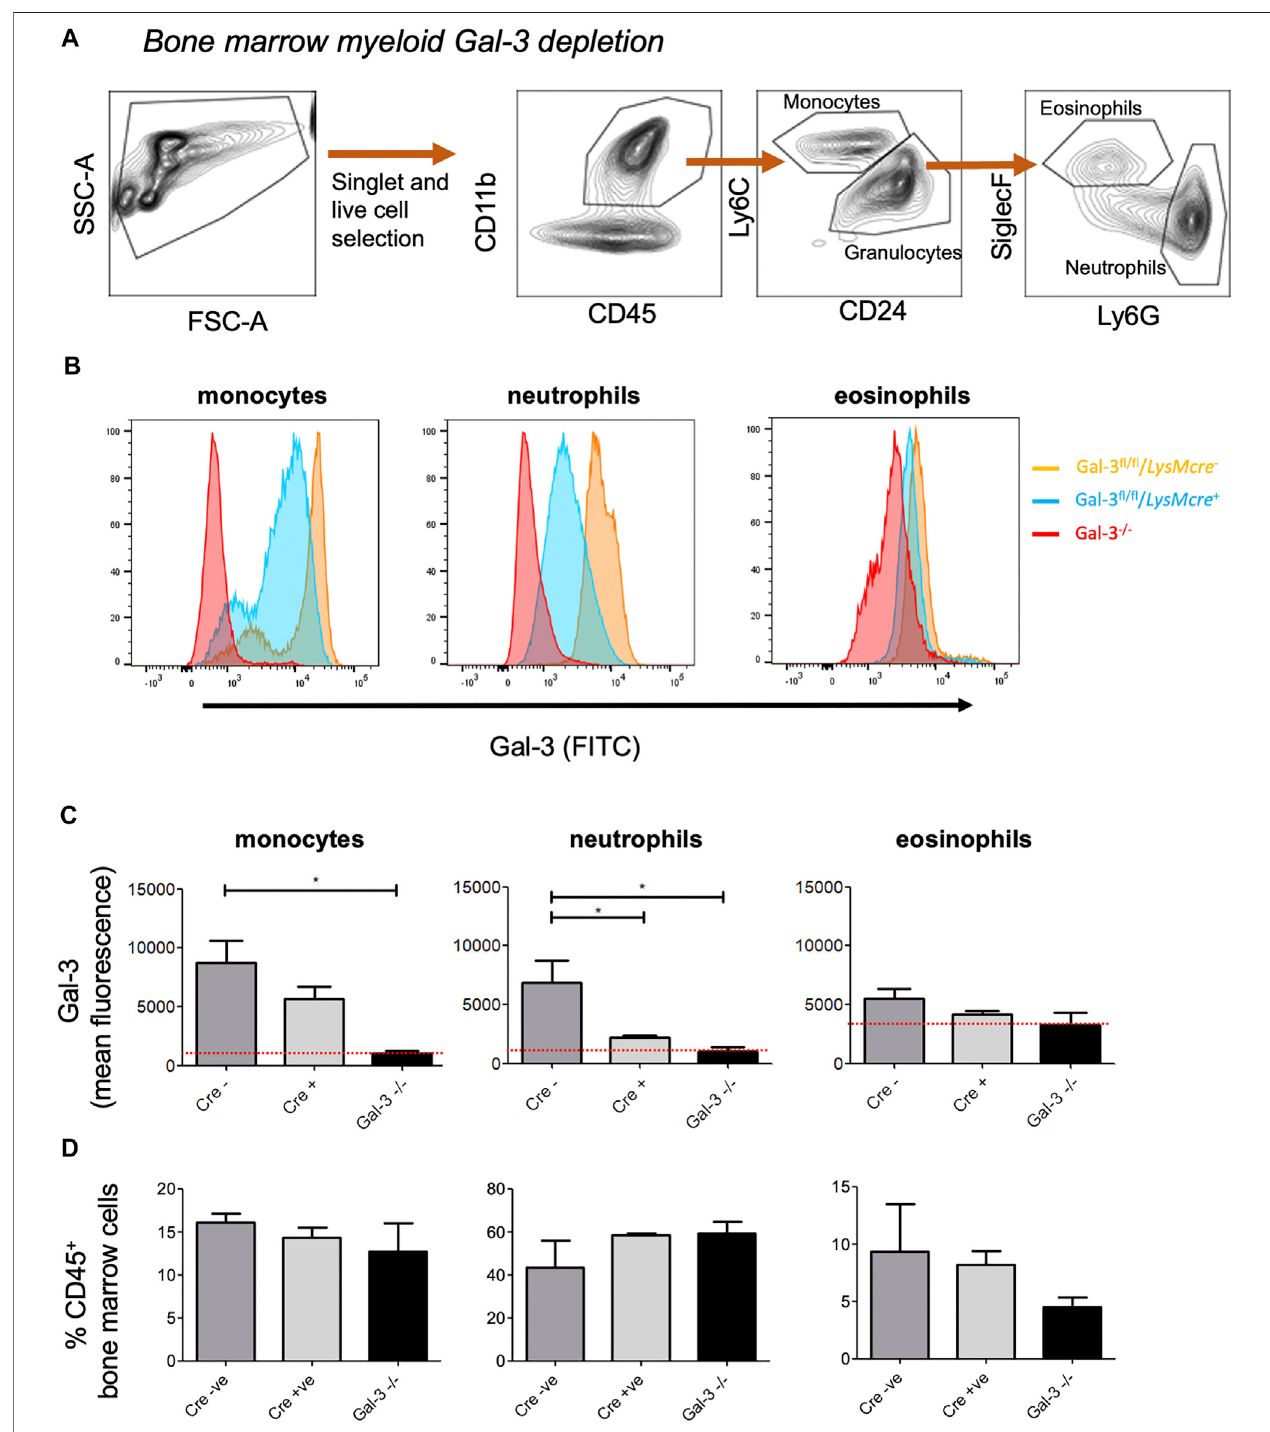
FIGURE 1 | – Con fi rmation of Myeloid cell Gal-3 depletion using bone marrow-derived leukocytes. (A) Gating strategy to identify monocytes (CD45 + , CD11b + , Ly6C + , CD24 − ), neutrophils (CD45 + , CD11b + , Ly6C − , CD24 + , Ly6G+, SiglecF − ) and eosinophils (CD45 + , CD11b + , Ly6C − , CD24 + , Ly6G − , SiglecF + ) in bone marrow leukocytes. (B) Gal-3 expression in bone marrow-derived leukocytes. Gal-3 expression on was assessed via fl ow cytometry. (C) Quanti fi cation of Gal-3 expression on monocytes, neutrophils and eosinophils. Red line represents mean fl uorescence intensity (MFI) in Gal-3 − / − mice. (D) Proportion of monocytes, neutrophils and eosinophils in the bone marrow. Data represented as mean ± SEM. Analysed via 1-way ANOVA ( n (cid:1) 6, * p < 0.05, ** p < 0.01, *** p < 0.001).